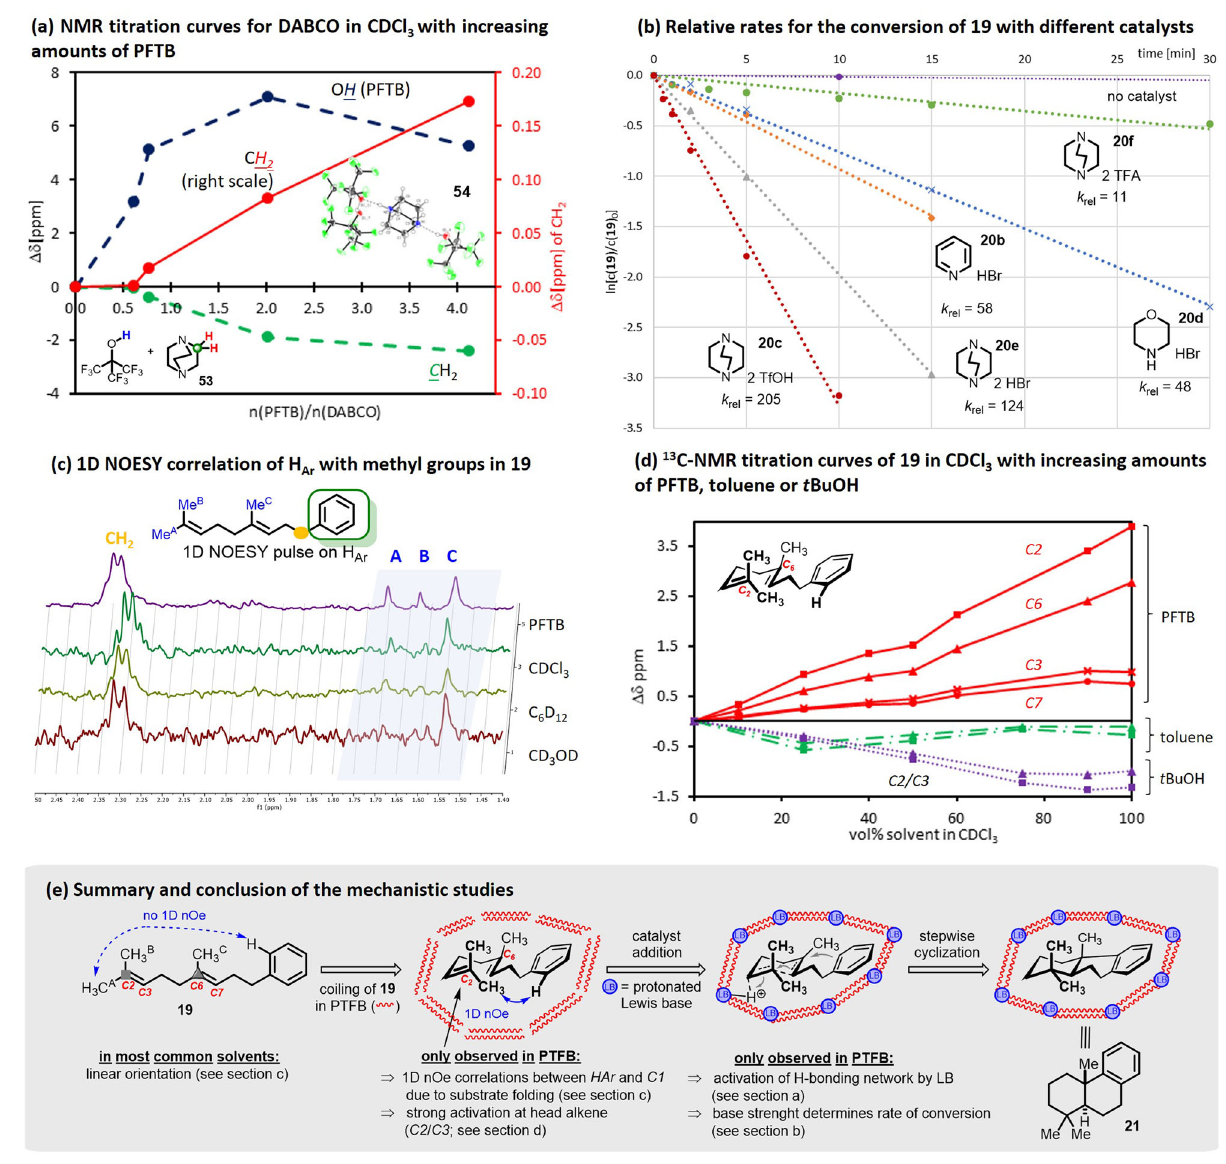
Fig.3|MechanisticInvestigations.a NMRtitrationcurveforDABCO( 53 )inCDCl 3 with increasing amounts of PFTB shows the interaction of the alcohol with the Lewisbase.Insert:CrystalstructureofDABCO(PFTB) 3 salt( 54 ). b Relativeratesfor conversionof 19 with different catalysts. For moreexperimentaldetailssee the